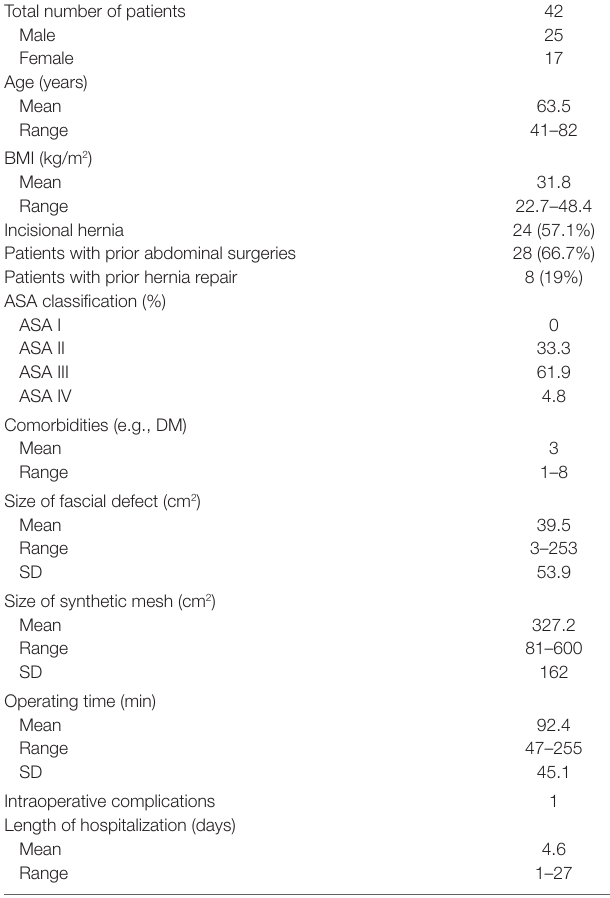
tABLe 1 | Patient characteristics and operative data.